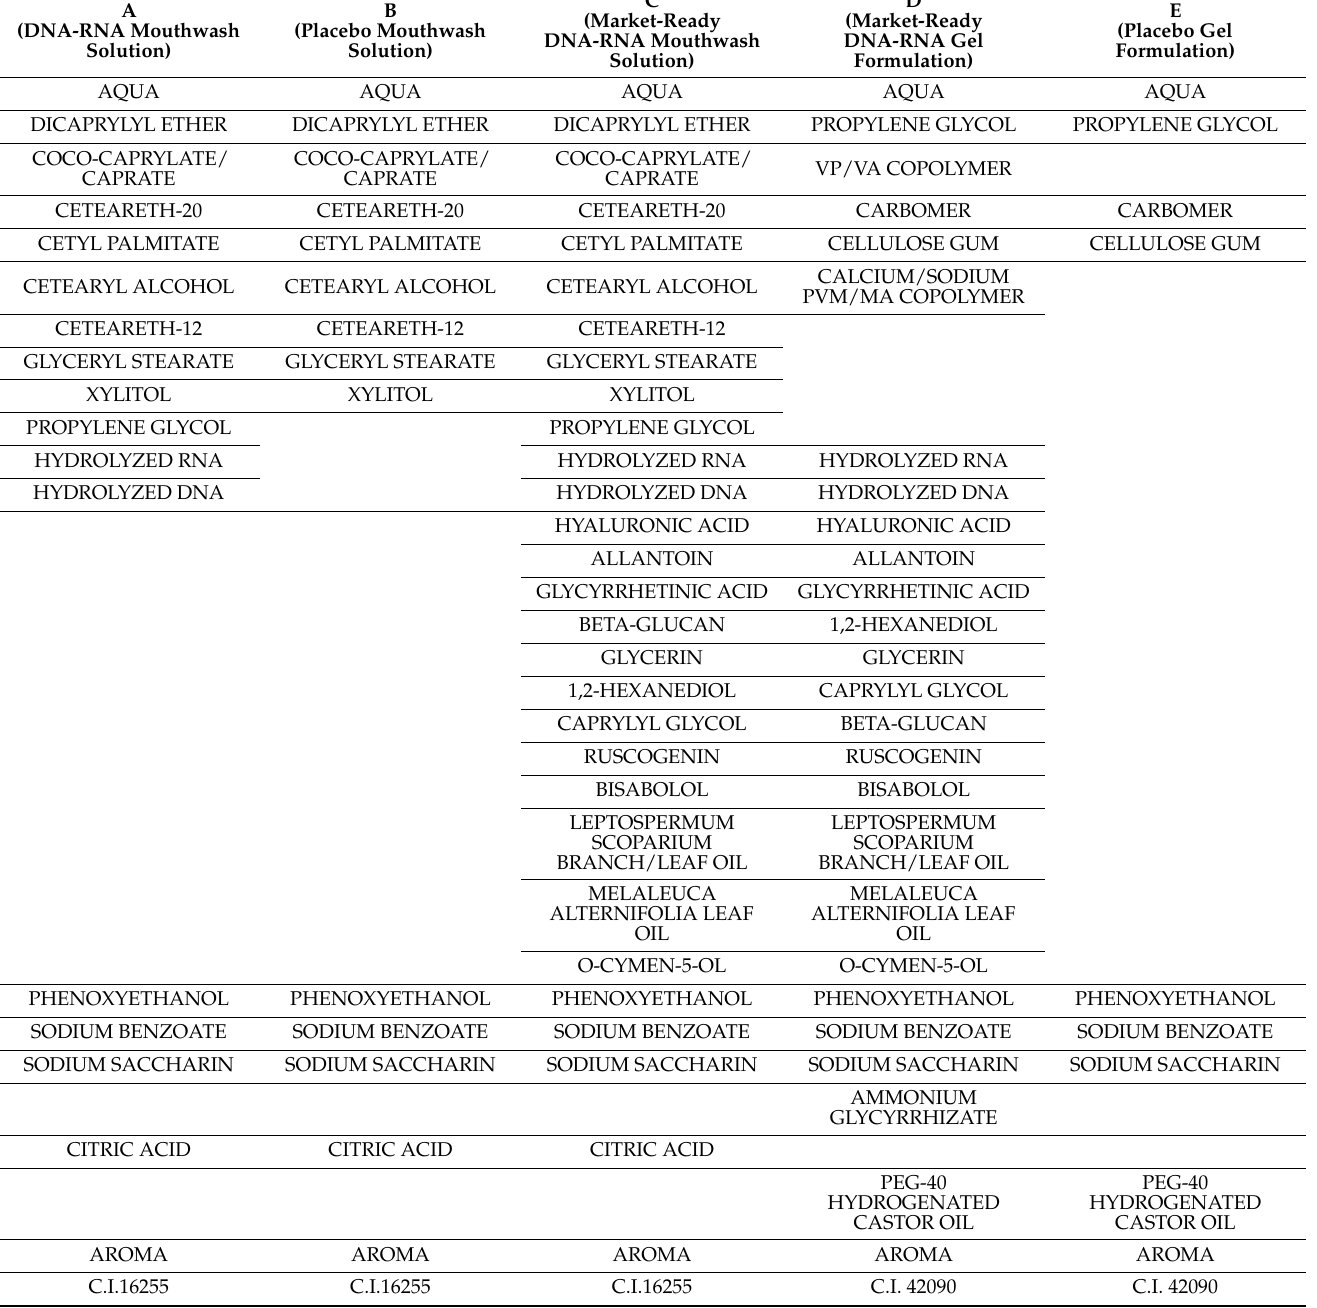
Table 1. Ingredients of the formulations tested in the present